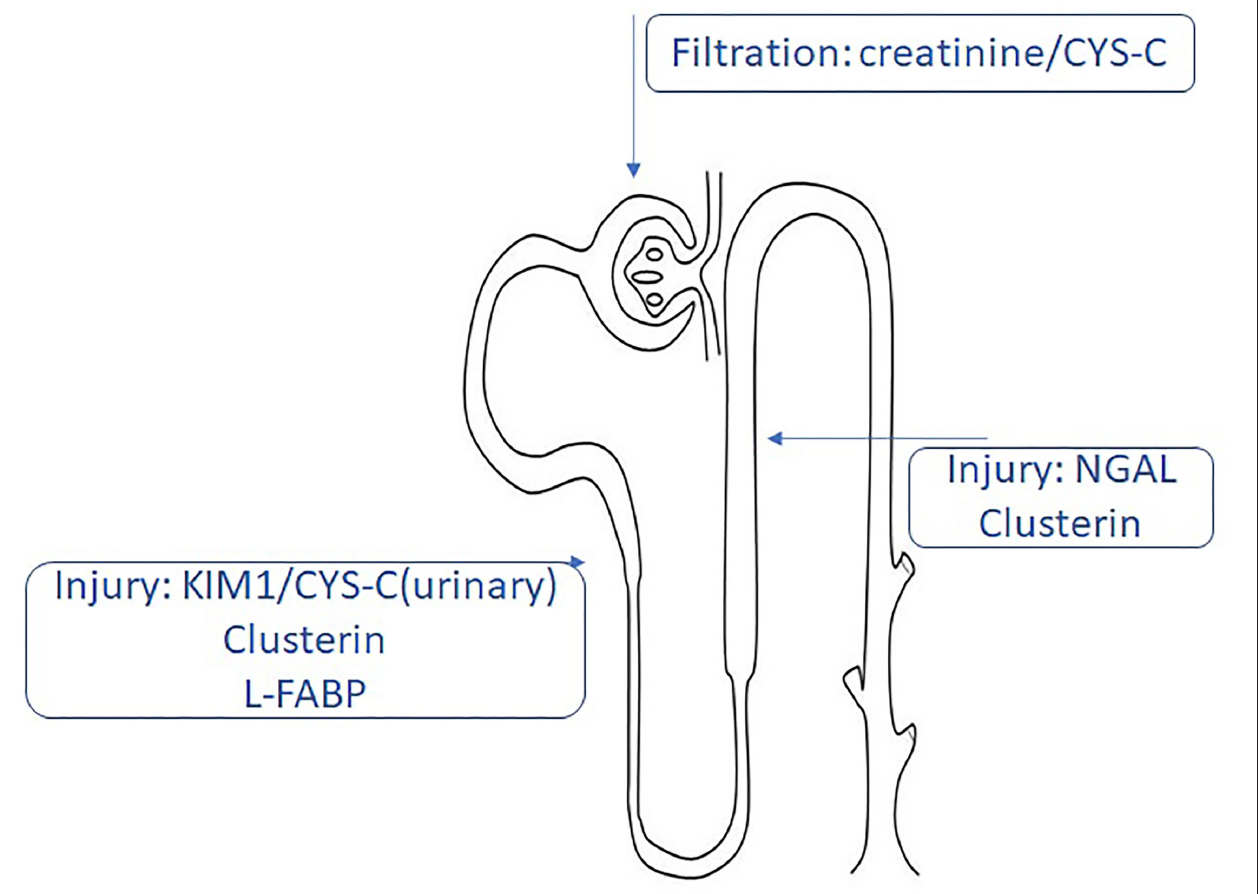
FIGURE 1 | Traditional and new biomarkers that can indicate kidney